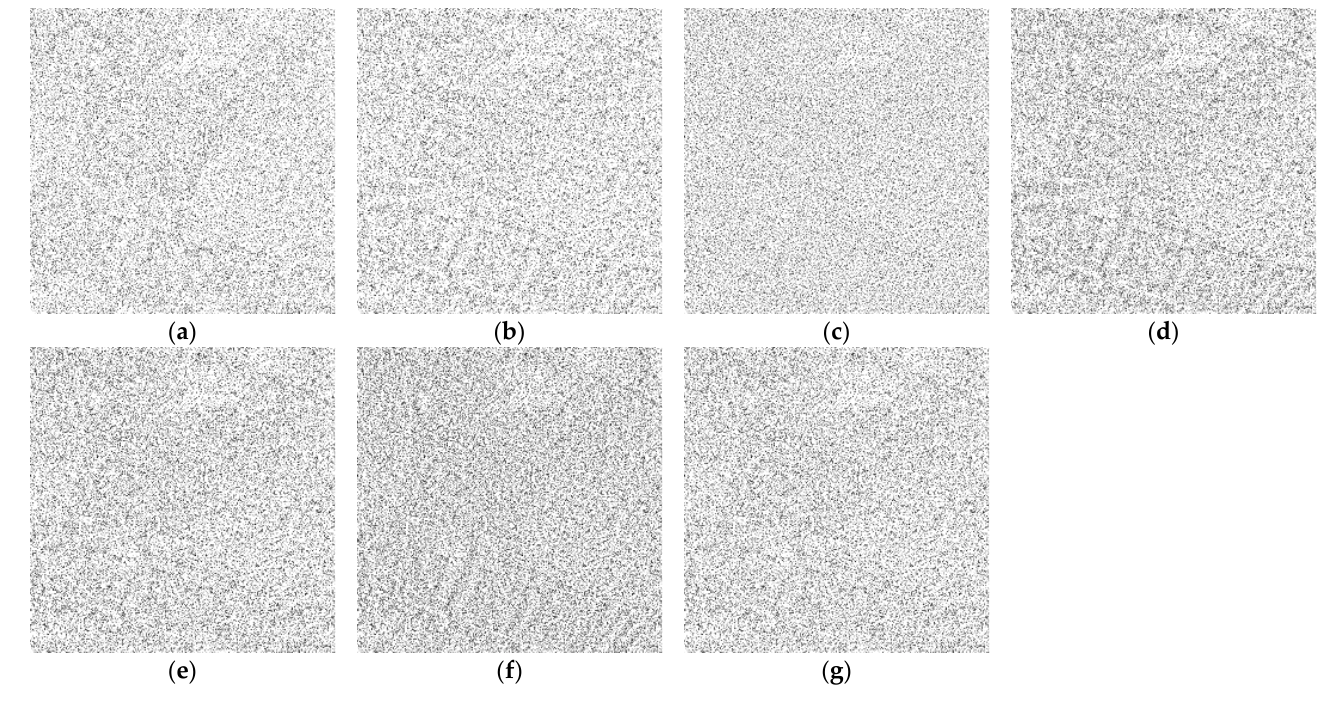
Figure 14. The corresponding ratio images for RS1. ( a ) W-C; ( b ) PPB; ( c ) SAR-BM3D; ( d ) H-WNNM; ( e ) GNLM; ( f ) FANS; ( g ) Proposed method.